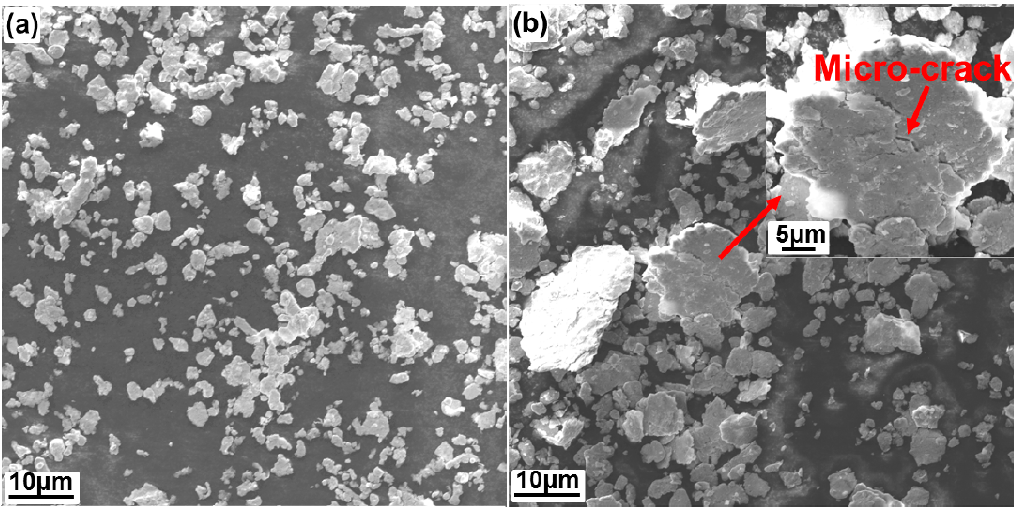
Figure 4. SEM images of powder mixture milled for ( a ) 8 h and ( b ) 48 h with 0.5 wt % of SiC in the initial powder mixture (shown at 10 nm resolution).